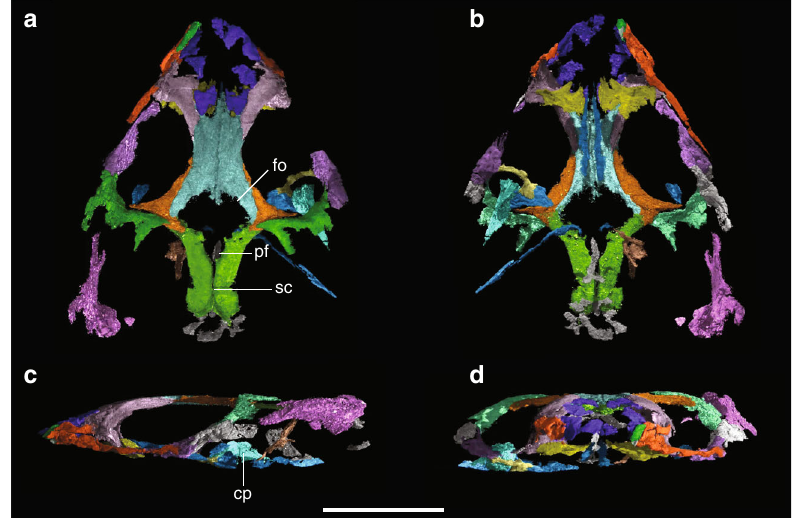
Fig. 1 Reconstructed skull of Colobops noviportensis . Three-dimensional volume rendering of the skull of Colobops noviportensis (YPM VPPU 18835) produced in VG Studio Max 3.0 in a dorsal, b ventral, c left lateral, and d anterior views. Gray portions indicate portions of the skull of uncertain homology. Scale bar equal to 1 cm. Abbreviations: cp, coronoid process; fo, fontanelle; pf, parietal foramen; sc, sagittal